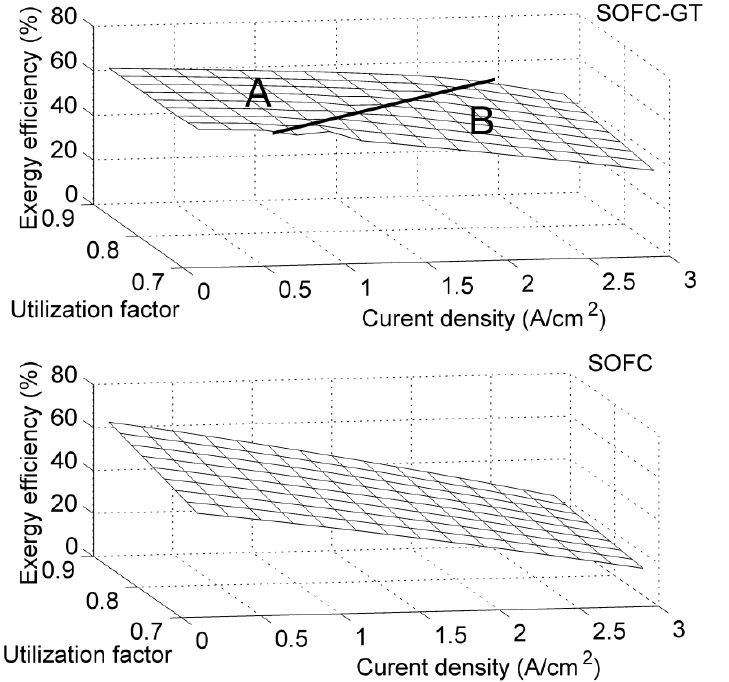
Figure 3. The effect of current density and fuel utilization factor on the efficiency of both = 600 systems; T FC